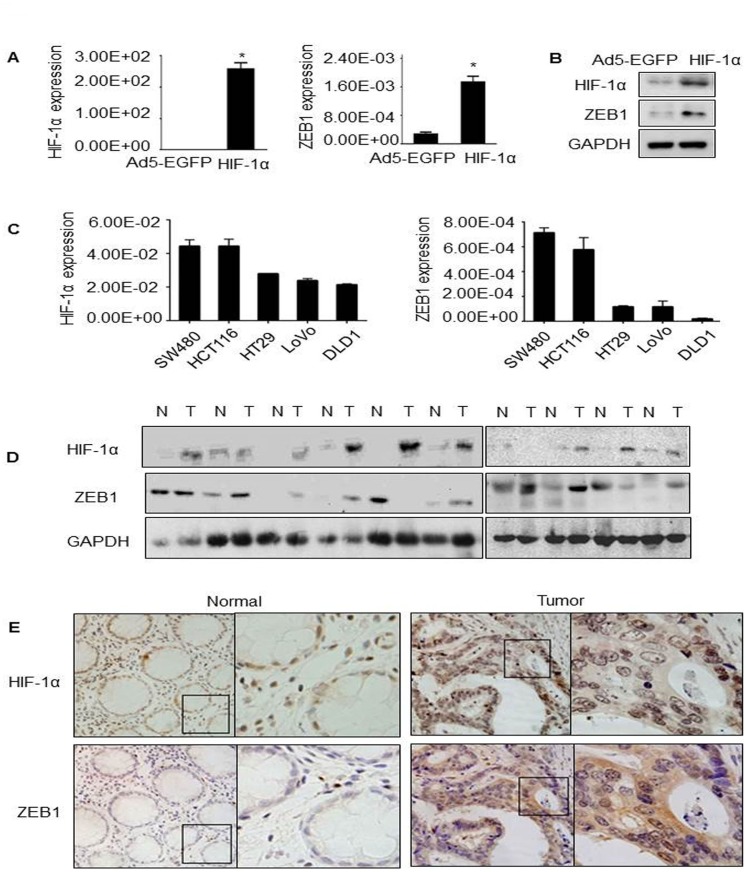
Regulation of HIF-1α on ZEB1 and their expressions in CRC.(A) Endogenous expression levels of HIF-1α and ZEB1 in the indicated five cell lines were detected by qPCR with GAPDH used as the internal control. (B&C) HT29 cells were transduced with Ad5-HIF-1α or control viruses for 48 hours, following by qPCR and western blot to detect the expression of HIF-1α and ZEB1. GAPDH was used as the internal control. (D) HIF-1α and ZEB1 protein levels in matched nonneoplastic/cancerous colorectal tissues. N: normal; T: tumor. The level of each protein was normalized against GAPDH. (E) Representative pictures of IHC staining on human CRC formalin-fixed paraffin-embedded samples for HIF-1α and ZEB1. Left panel showed the adjacent normal colorectal tissues. Right panel showed CRC specimens. Original magnification, 200X.